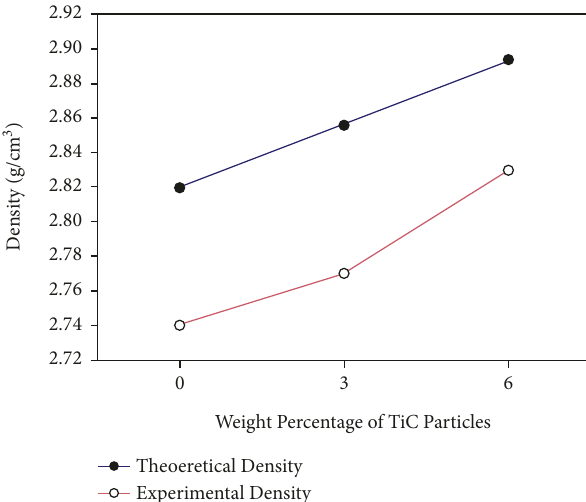
Figure 6: Density of Al7075 alloy with TiC composites.